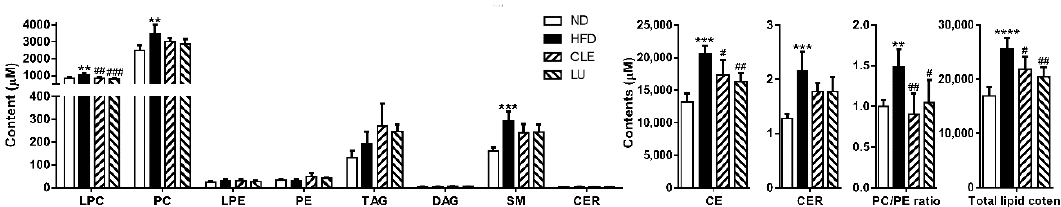
Figure 4. Overview of the e ff ects of Chrysanthemum morifolium Ramat leaf extracts and luteolin on the serum lipidome in obese mice. The total lipid contents are expressed as the sum of contents of all identified lipids in mice plasma. Lipid classes are indicated on the x -axis: LPC, lysophosphatidylcholine; PC, phosphatidylcholine; LPE, lysophosphatidylethanolamine; PE, phosphatidylethanolamine; TAG, triacylglycerol; DAG, diacylglycerol; SM, sphingomyelin; CER, ceramide; CE, cholesteryl ester. The data are shown as mean ± standard deviation (SD) ( n = 6). *, # di ff erent letters indicate significant di ff erence compared with the normal diet (ND) group (*) and high-fat diet (HFD) group (#), as determined by Tukey’s multiple comparisons test. CLE: HFD plus Chrysanthemum morifolium Ramat leaf extract 1.5% diet; LU: HFD plus luteolin 0.003% diet (** p < 0.01,